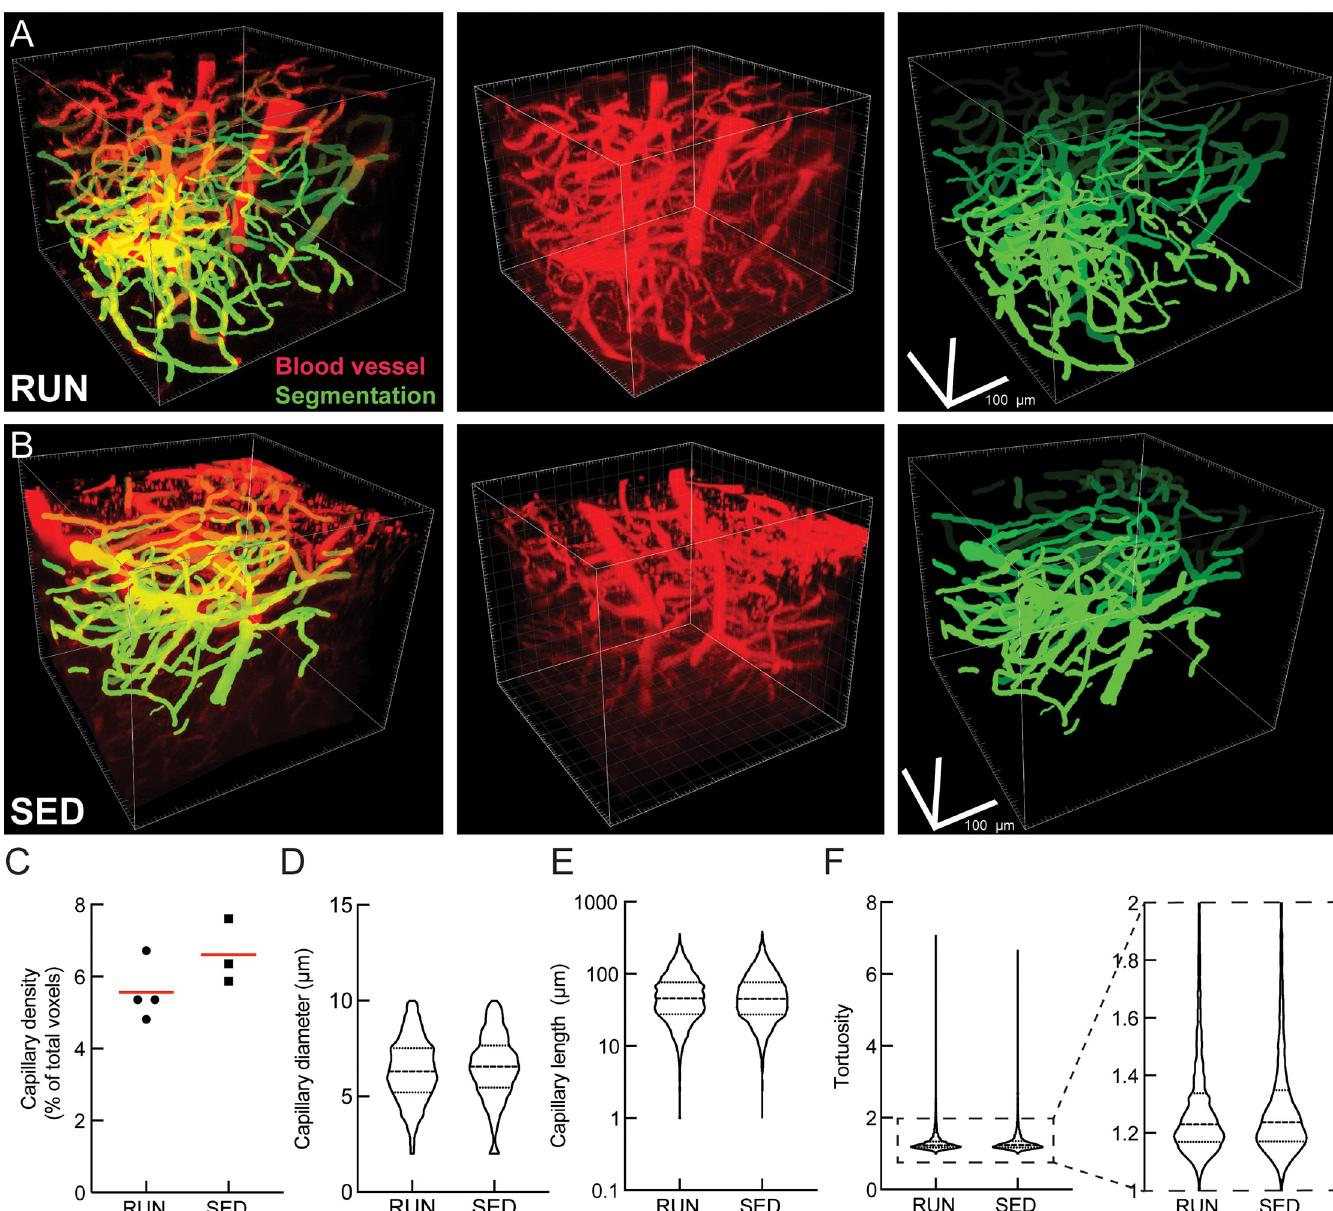
Fig 7. Running did not alter capillary density or geometry. A and B Representative 2PEF image stacks of fluorescently-labeled cortical vasculature (middle) and the segmentation of this image (right) from running (RUN) and sedentary (SED) APP/PS1 mice, respectively. C Density; D Diameter; E Length and; F Tortuosity of capillary segments from running (RUN; n = 5514 capillaries) and sedentary (SED; n = 7251 capillaries) APP/PS1 mice.